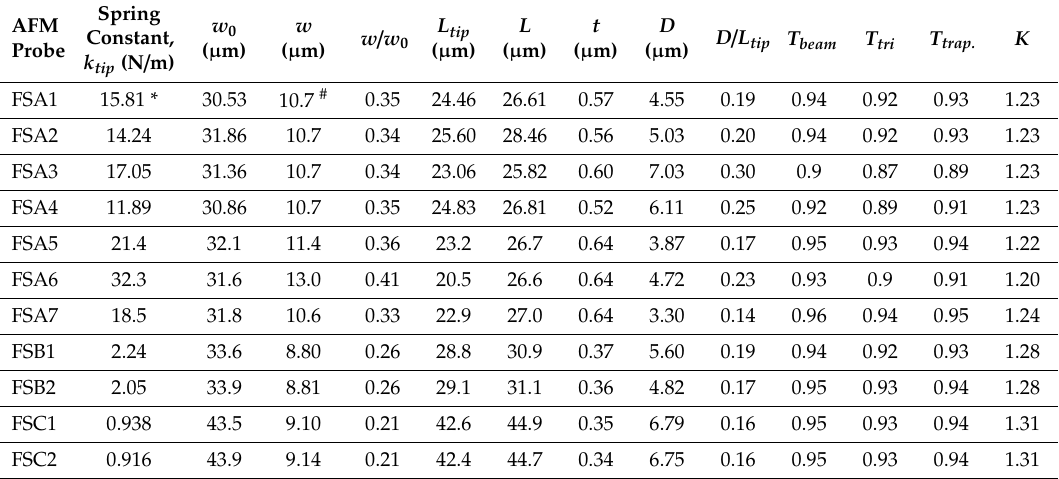
Table 1. Shows spring constant, dimensional data, torque corrections, and K correction factors for a variety of Bruker FastScan Atomic Force Microscopy (AFM)